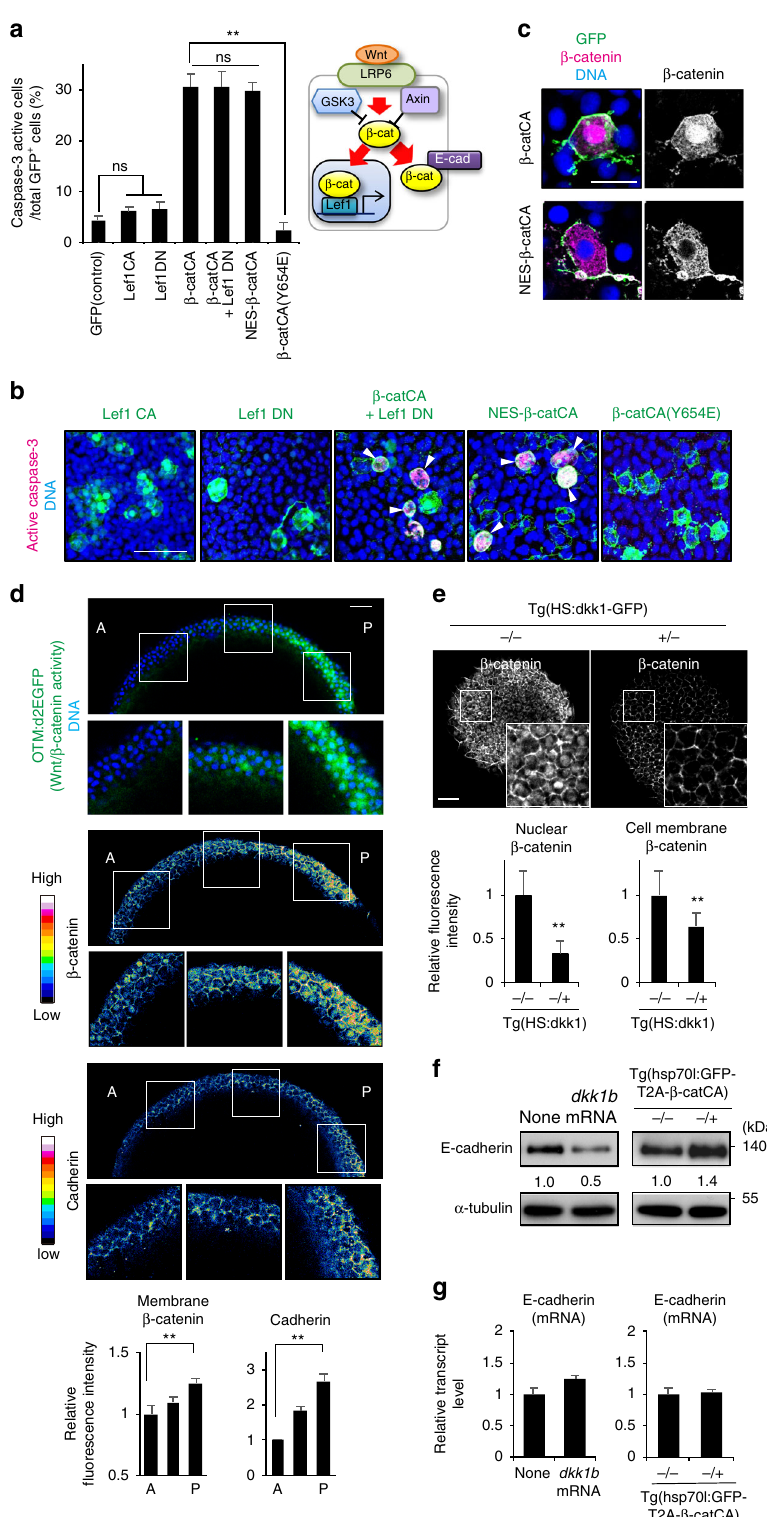
an imbalance of cadherin levels between un fi t and neighbouring cells. Un fi t cells also activate TGF- β -Smad signalling to produce ROS and consequently undergo ROS-mediated apoptosis. In this manner, embryonic tissues eliminate excess noise from the Wnt/ β -catenin gradient to support its proper formation along with robust embryonic patterning.